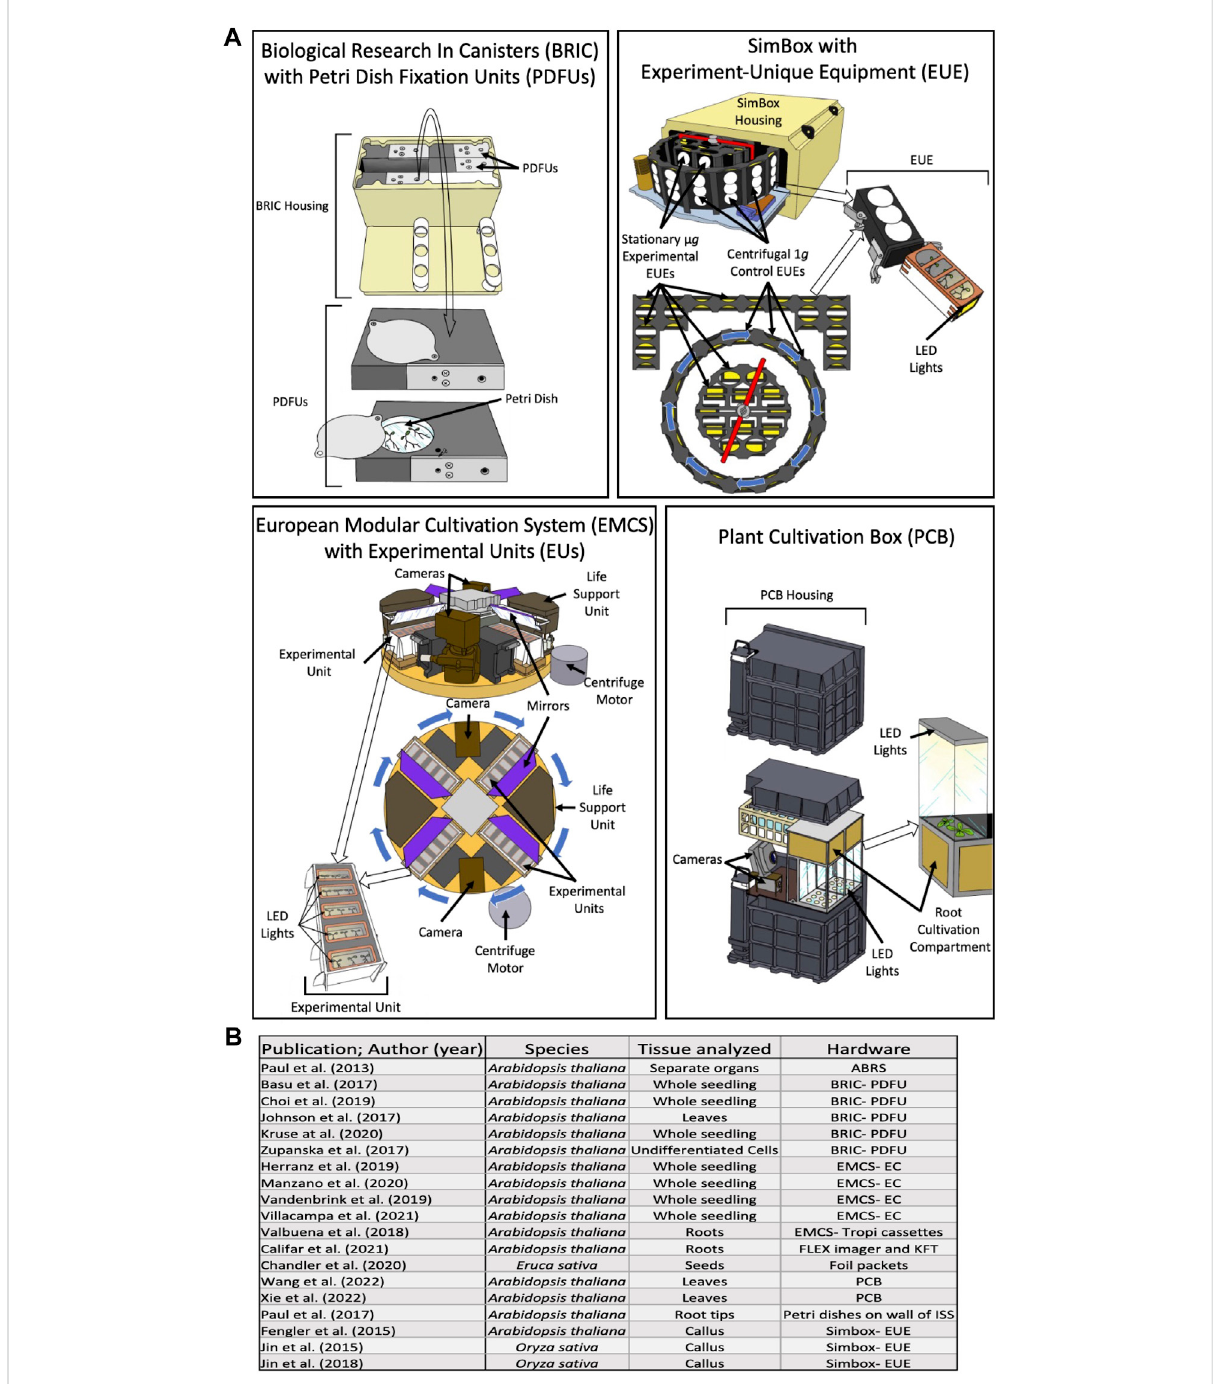
FIGURE 1 (A) Diagrams of the space fl ight hardware used in more than one of the plant biology studies in this review. Circles of arrows indicate centrifuge rotation capability. (B) Summary of the hardware, species and sampled tissues utilized in recent space fl ight experiments. LED light locations are indicated with arrows. EUEs in the center of the SimBox centrifuge and in the back arranged in a bracket shape do not spin, and therefore act as the microgravity experimental group in the same space as the 1 g control EUEs loaded into the centrifugal ring. Abbreviations are: